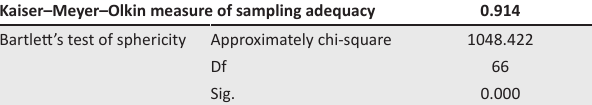
TABLE 6: Kaiser–Meyer–Olkin and Bartlett’s test (Section